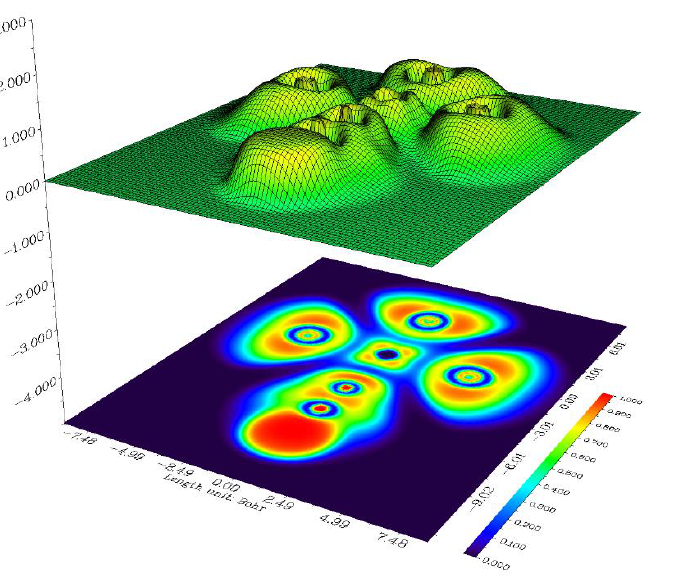
Figure 6. Electron localization function (ELF) analysis of the Cl 3 Au ··· NCH complex.